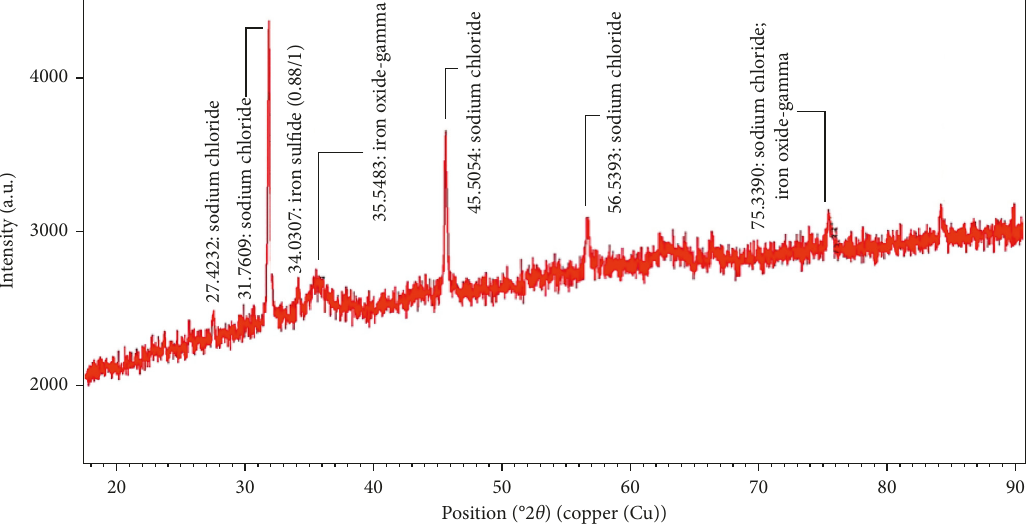
Figure 3: XRD spectrum of multicomponent nanoparticles.